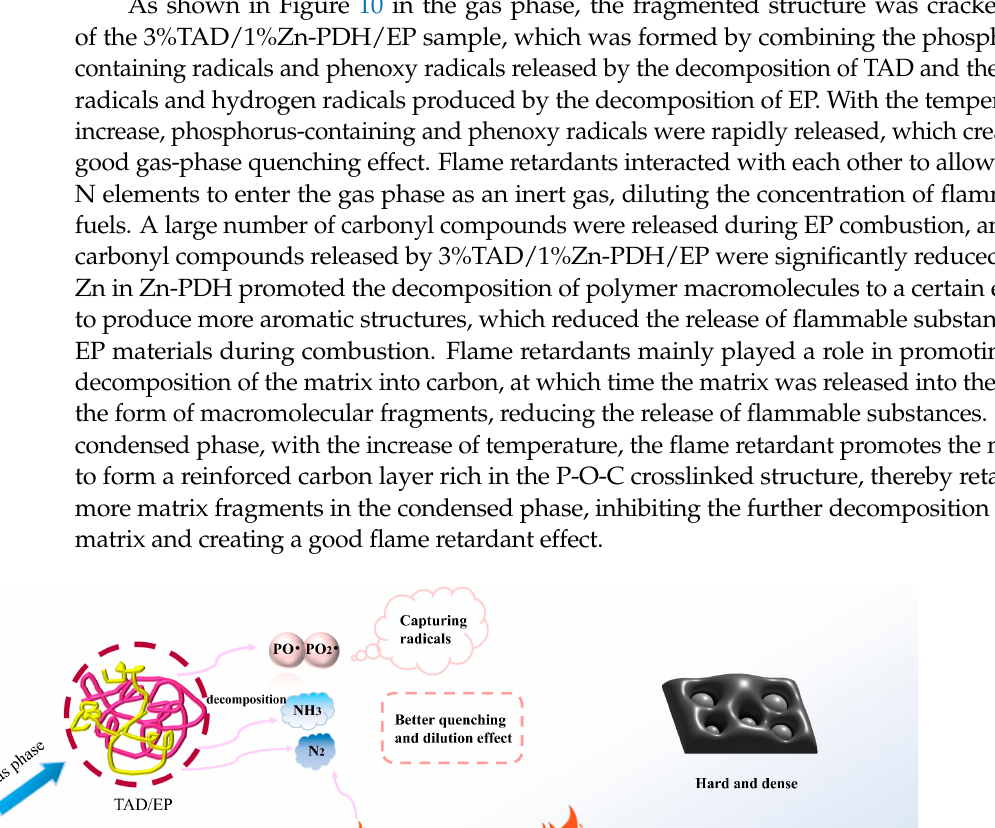
Table 8. Physicochemical and technological properties of components.